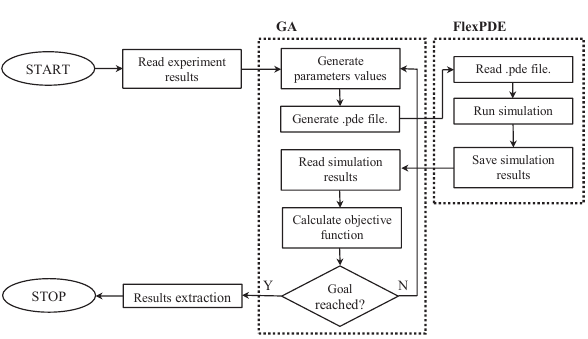
Figure 8. Scheme of operation of GA with FlexPDE. Figure 8: Scheme of operation of GA with